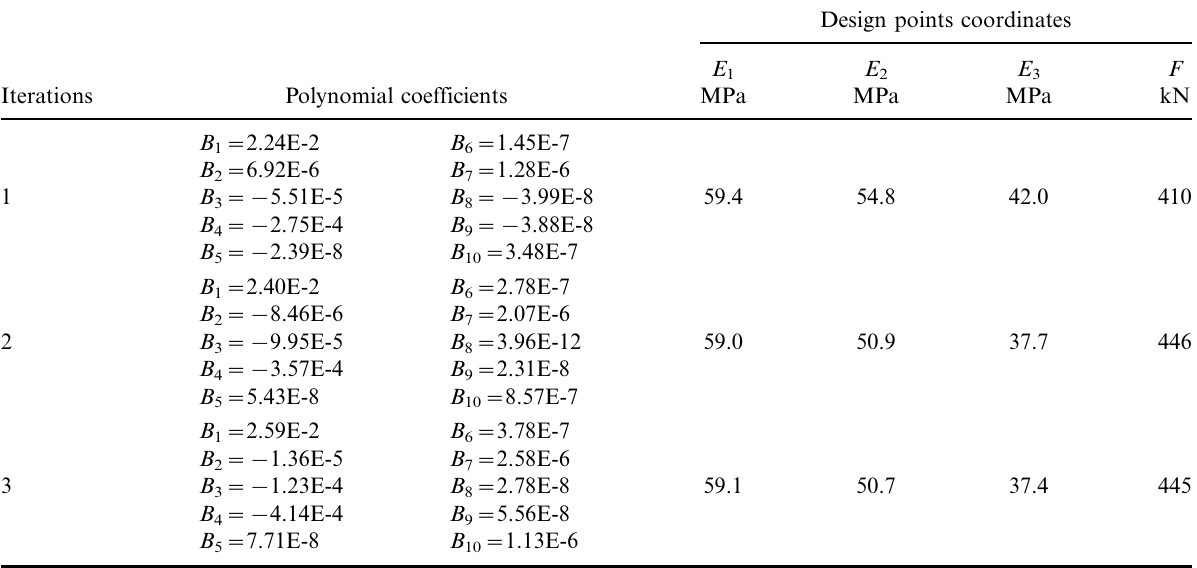
Table 2. Determined response surfaces for consecutive